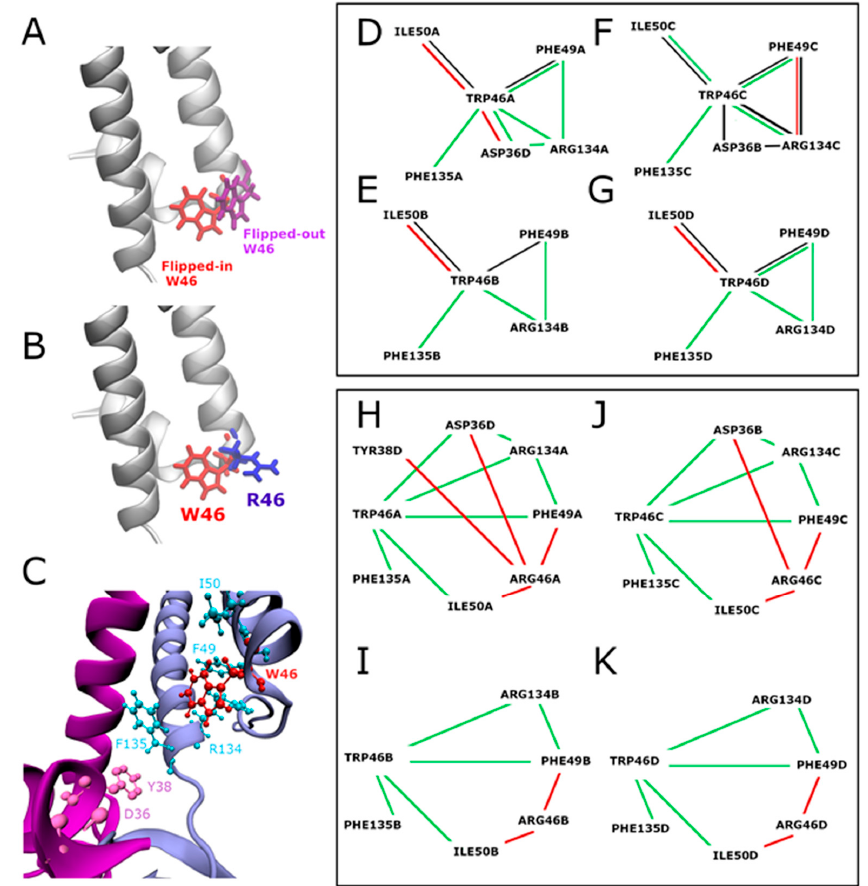
Figure 3. Overview of the network of interactions around W46 (KirBac3.1 WT) and R46 (KirBac3.1 W46R). ( A ) KirBac3.1 WT: representation of the W46 flipped-in (in red, from X-ray structure PDB 2WLJ) and the flipped-out (in purple, from a representative structure issued from MDeNM simula- tions [18]. ( B ) Superimposition of the residue W46 (flipped-in) in red and the mutation R46 in blue from our crystallographic structure. ( C ) Network of interactions around W46. The chains A and D are colored in blue and magenta, respectively, and the residue W46 (flipped-in) is in red. ( D – G ) KirBac3.1 WT: Comparison of the interaction network of residue W46 in flipped-in and flipped-out conformations for the chains ( A ) (panel ( D )), ( B ) (panel ( E )), ( C ) (panel ( F )), ( D ) (panel ( G )). The green lines indicate the interactions present in the flipped-in configuration but absent in the flipped- out one, and red lines those present in the flipped-out configuration but absent in the flipped-in one. Black lines are shared between the two conformers. ( H – K ) Comparison of the interaction network of residue W46 flipped-in (KirBac3.1 WT) and residue R46 (KirBac3.1 W46R) for the chains ( A ) (panel ( H )), ( B ) (panel ( I )), ( C ) (panel ( J )), ( D ) (panel ( K )). The green lines indicate the interactions present in KirBac3.1 WT but absent in the W46R mutant, and the red lines the interactions present in the W46R mutant but absent in KirBac3.1 WT. For more details, see Figure S2.